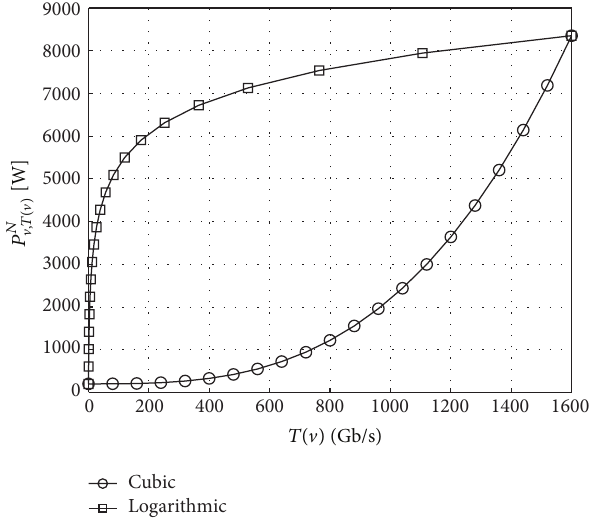
Figure 3: Power consumption of node V , 𝑃 𝑁 V ,𝑇( V ) = 𝑃 𝐶 V + 𝑃 RP V ,𝑇( V ) .